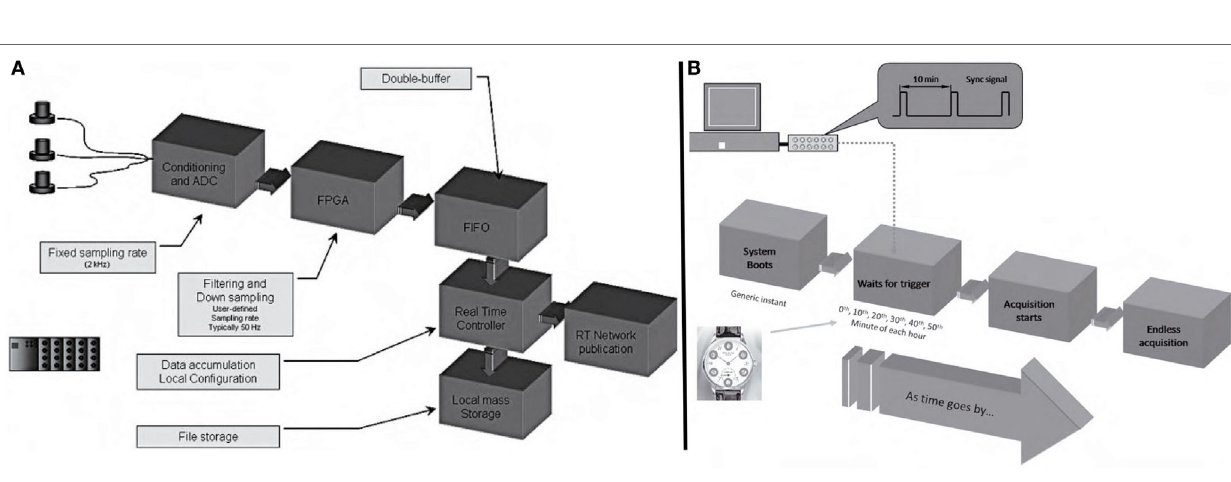
FiGURe 13 | (A) Data acquisition and management logics and (B) synchronization logics. Reprinted from (Cigada et al., 2010).